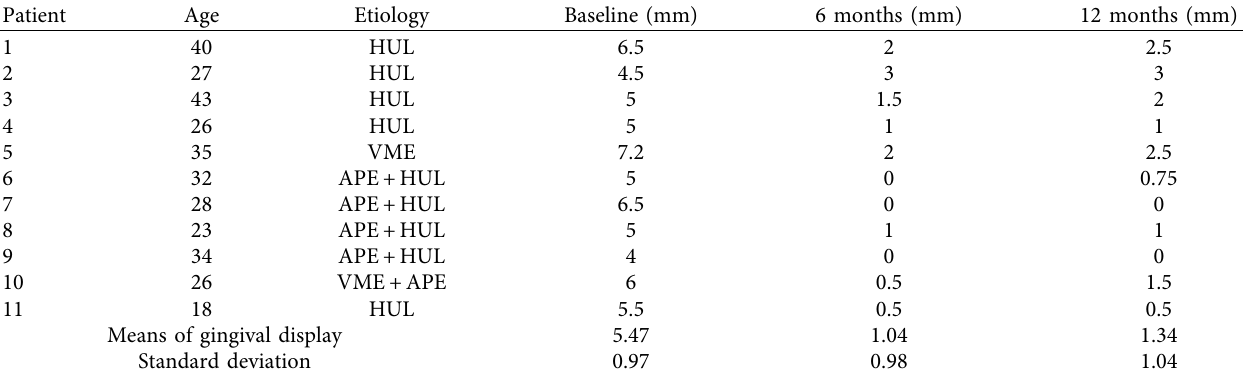
Table 1: Data, means, and standard deviation of gingival display before the surgery and 6 and 12 months after surgery. Patient